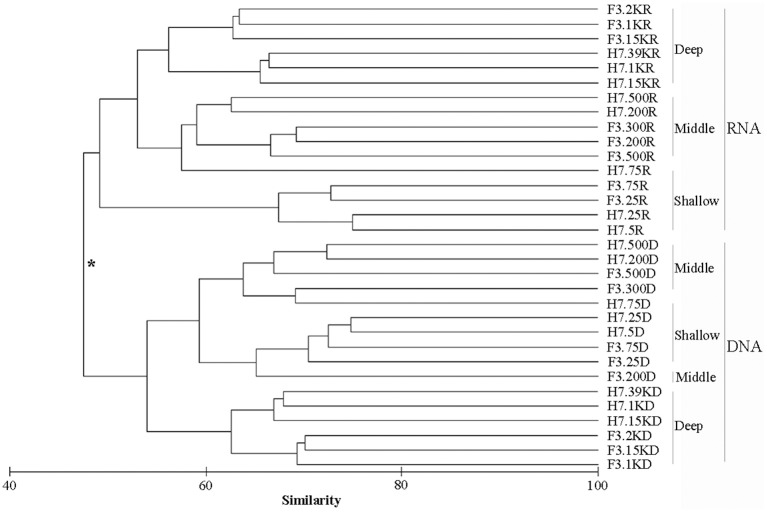
Cluster diagram of Bray-Curtis similarities calculated from square-root transformed relative OTU abundances for each sample. The asterisk at the node in the dendrogram separating DNA and RNA surveys indicates significant compositional differences between these two groups (R = 0.5506, p = 0.0001) determined by the ANOSIM.